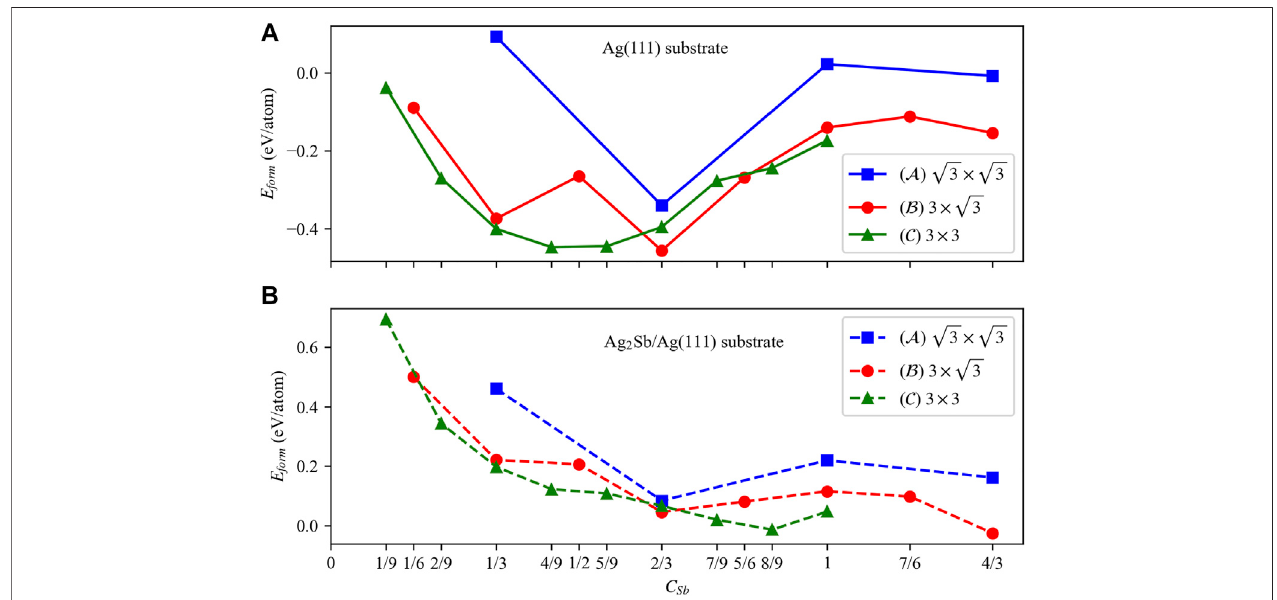
FIGURE 1 | The formation energies of the Sb atoms adsorbed on different types of pure Ag (111) and Ag 2 Sb/Ag (111) substrates. (A) and (B) show the evolution curves of the formation energy, where blue, red, and green represent Ag 2 Sb/Ag (111) substrates,